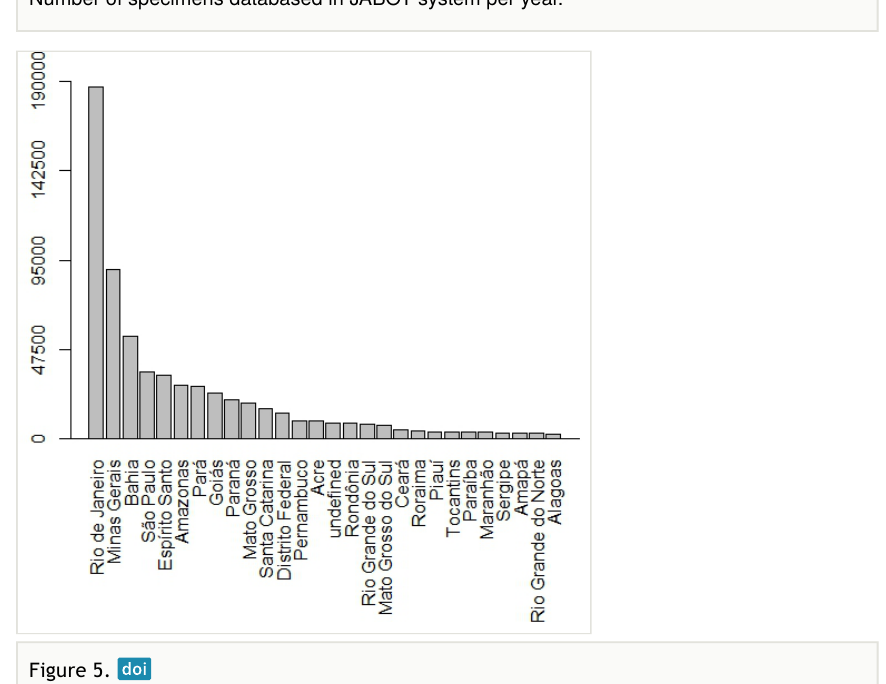
Figure 5. Number of vouchers per Brazilian states deposited in the RB